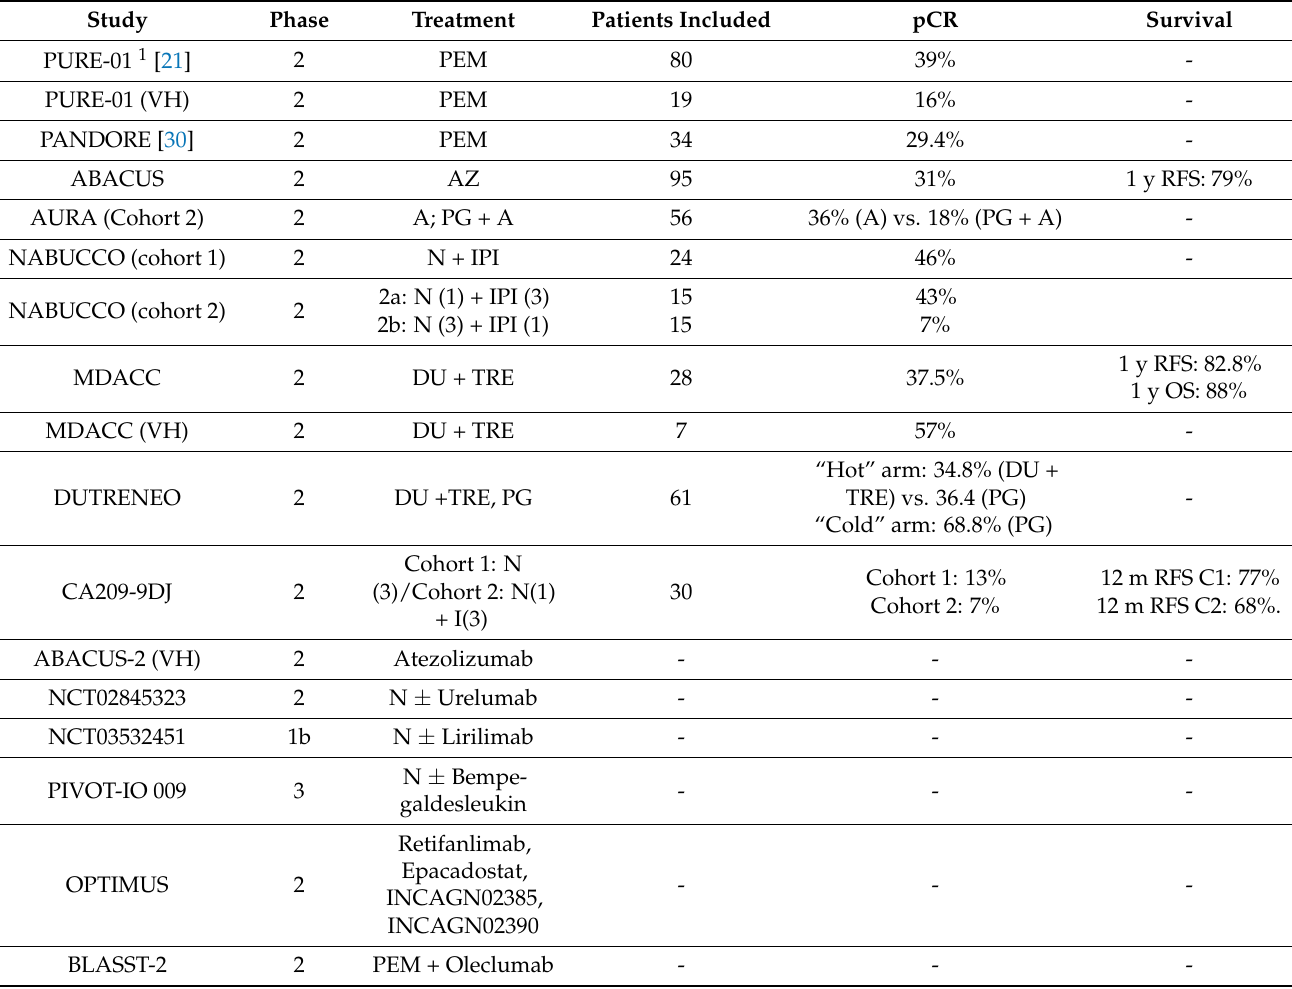
Table 2. Summary of completed, active, or currently recruiting studies with immunotherapy agents without